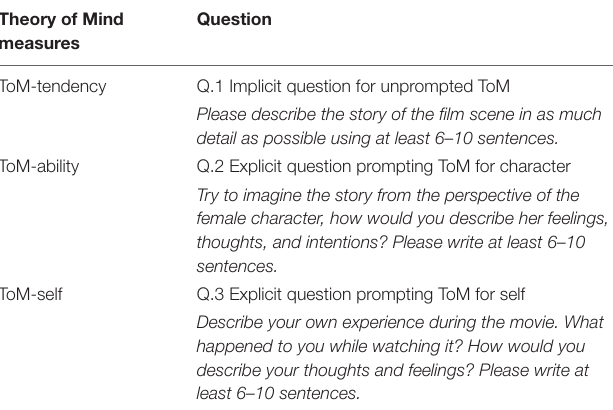
TABLE 1 | Description of questions used after viewing and the nature of ToM that they access.